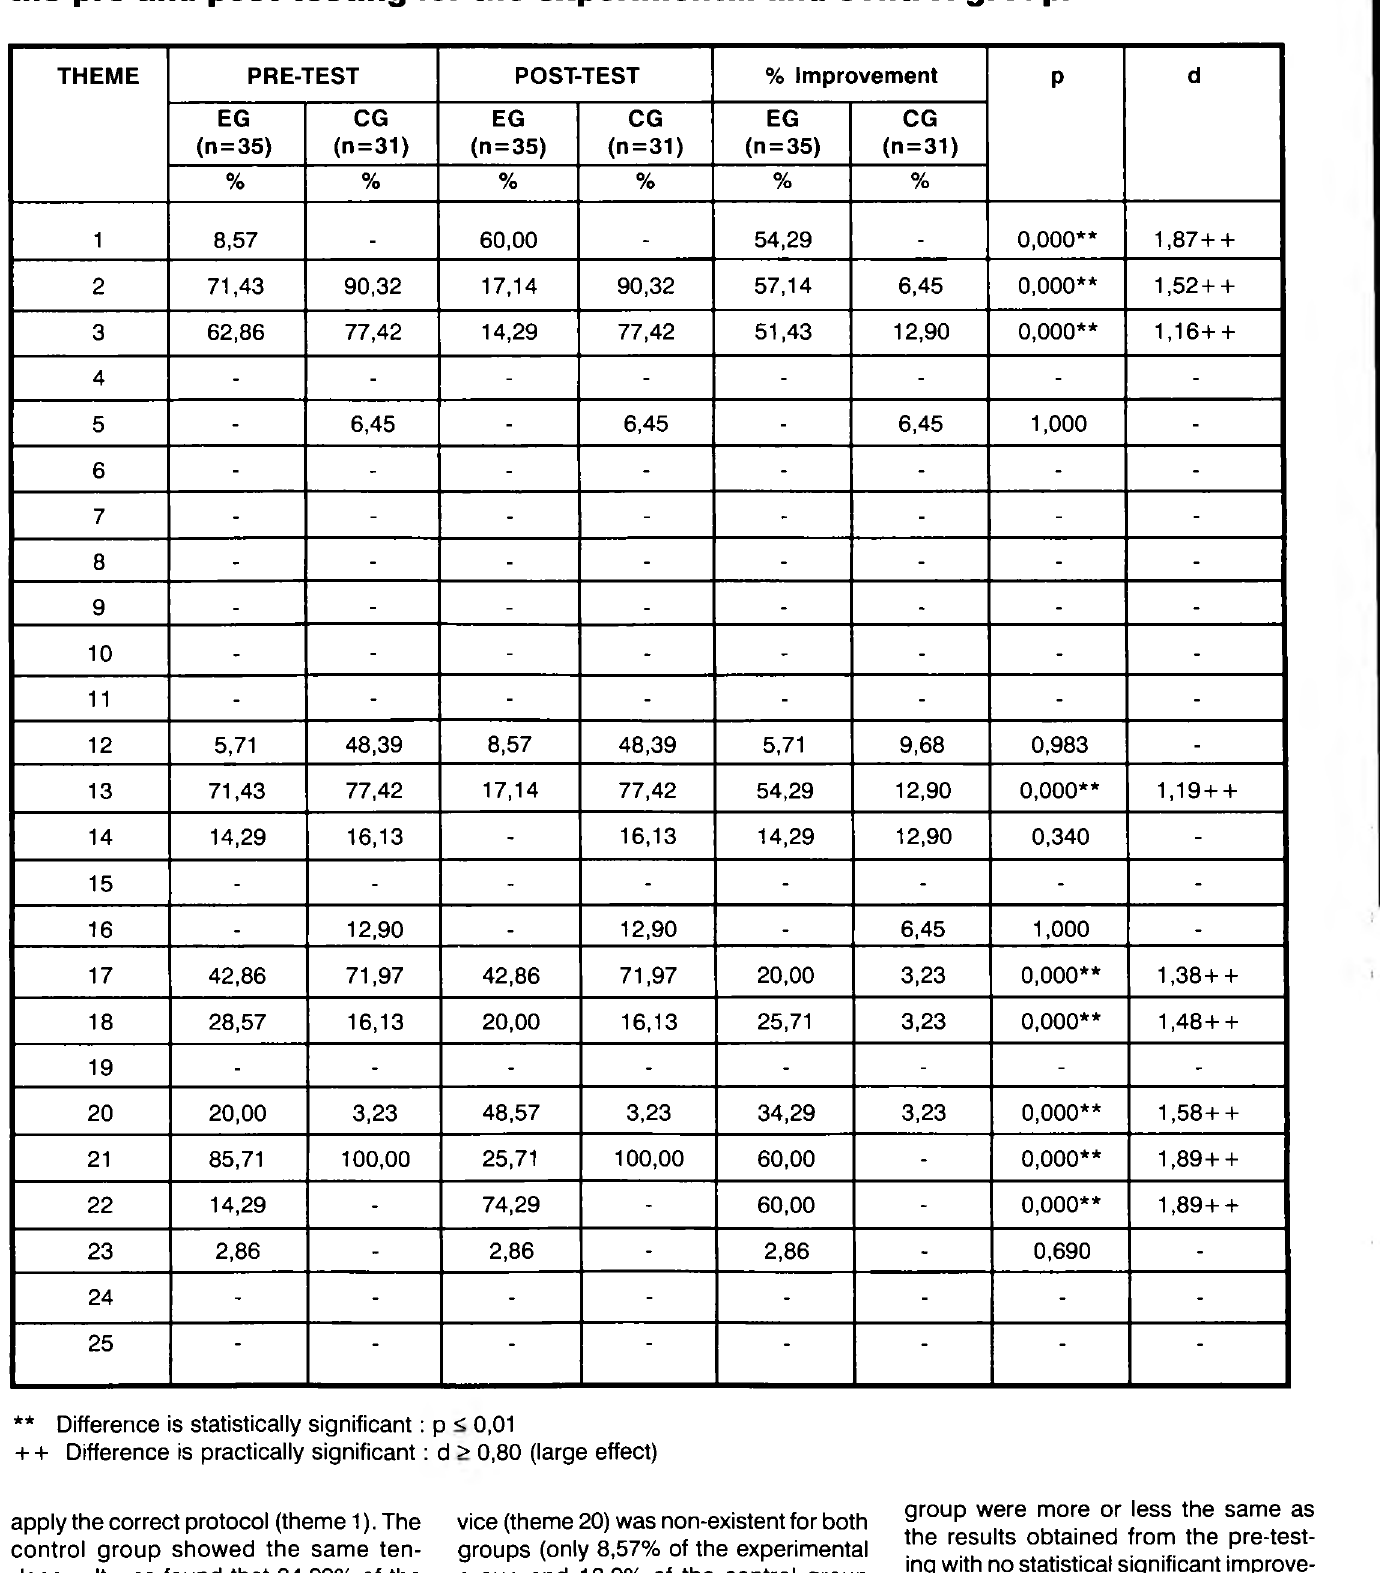
Table 1 : A comparison of the m edicine utilisation in case study 1 betw een the pre and post-testing for the experim ental and control